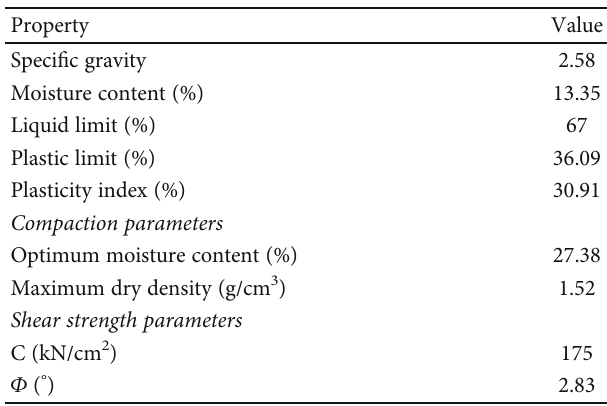
Table 1: Index properties of